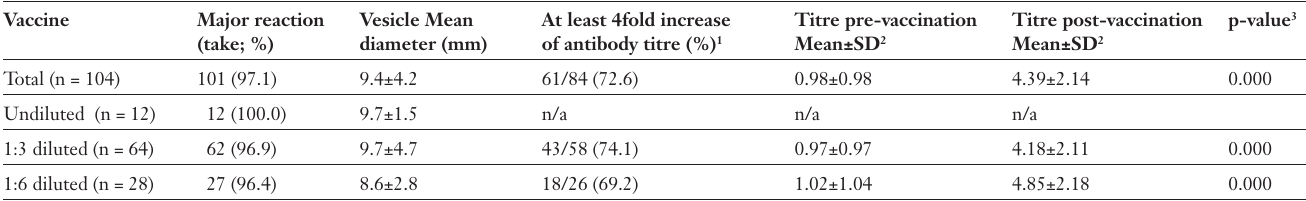
Vaccine Major reaction Vesicle Mean